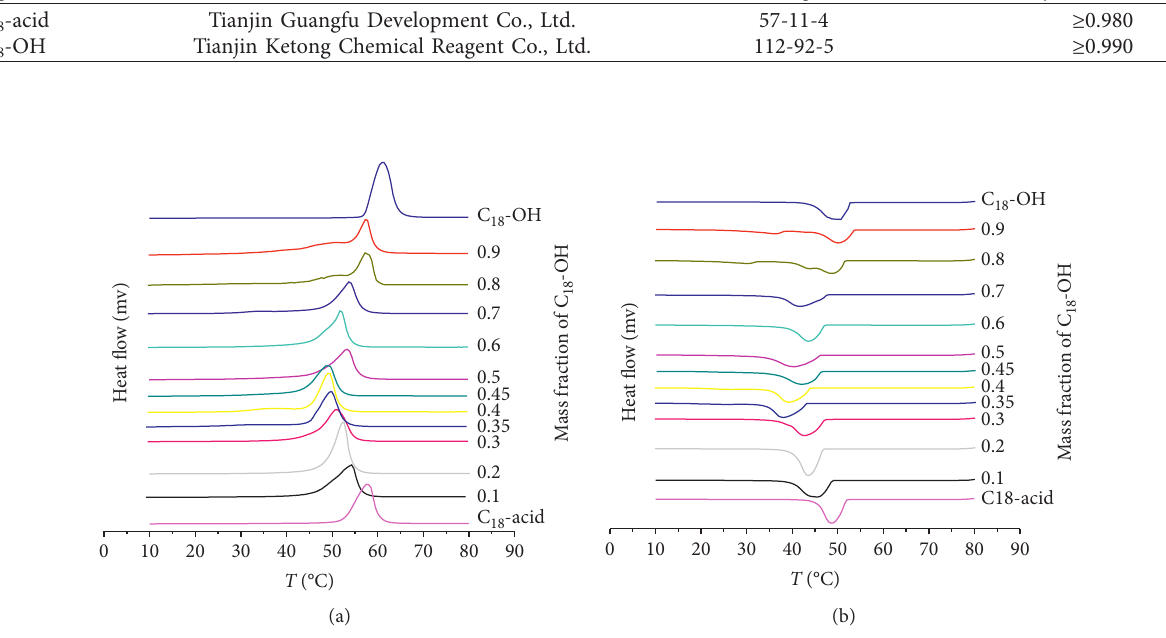
18 -acid and C 18 -OH.